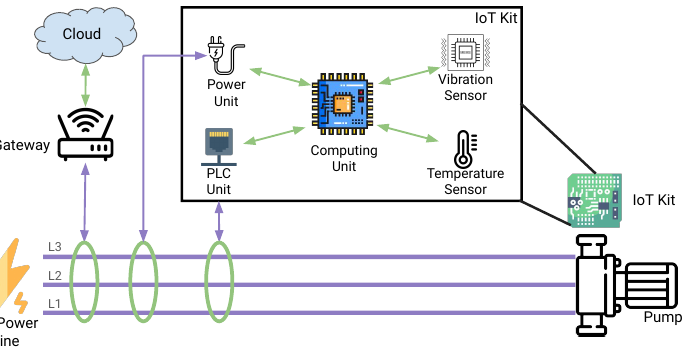
Figure 3. Schema of the proposed system: the rotating pump where the sensor is installed, the power line used for energy and communication, the gateway, and the cloud/external